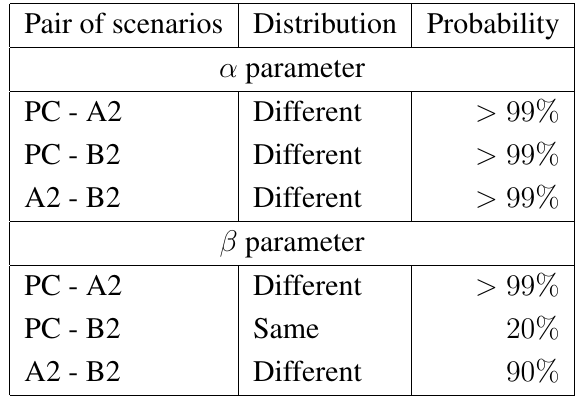
Table 3. Resume of results for the runs tests comparing the distributions of the fit α and